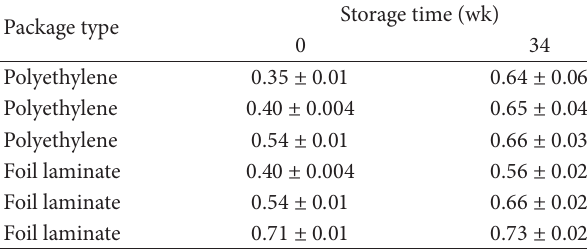
Table 1: Initial and final 𝑎 and 75% RH for 34 weeks a